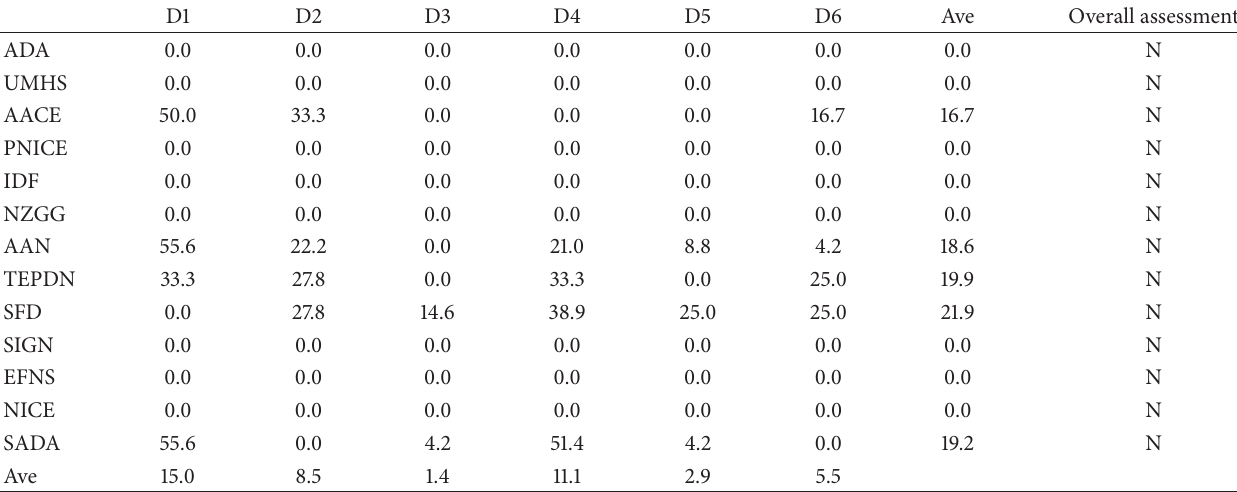
Table 6: Results of the assessment of the recommendations regarding treatment based on pathogenetic mechanisms using the AGREE II instrument (domain scores in